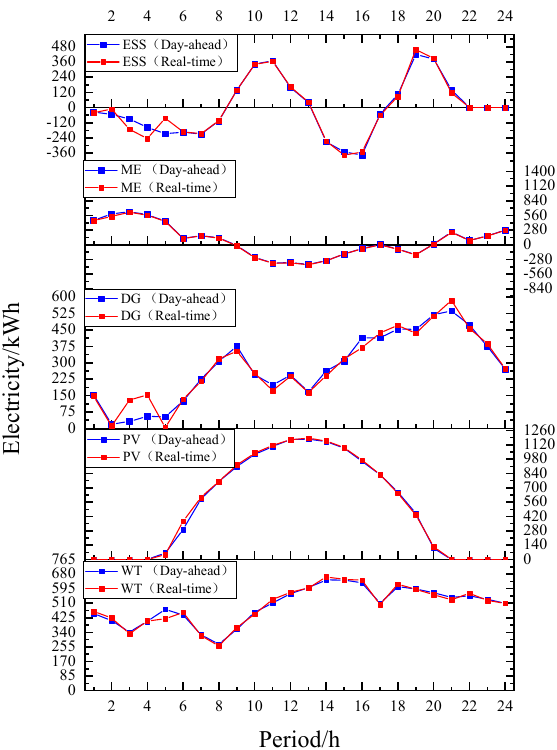
Figure 8. The comparison of the two-stage optimal scheduling results.